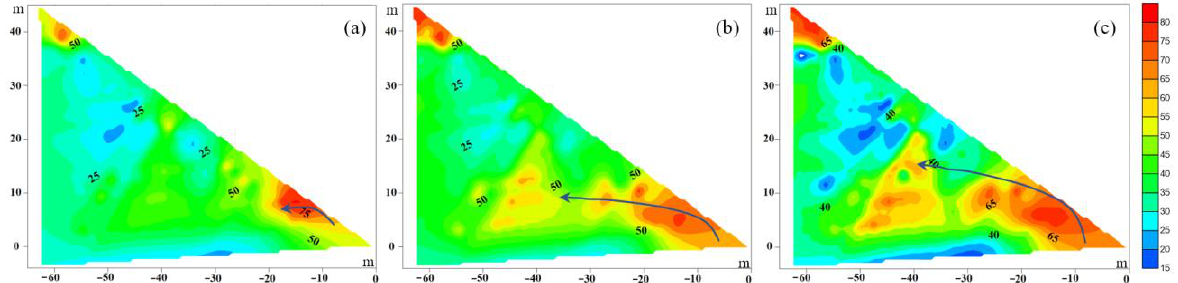
Figure 6. Development monitoring map of the damaged area: ( a ) damage at the beginning of mining, ( b ) damage at the middle of mining, and ( c ) damage at the end of mining